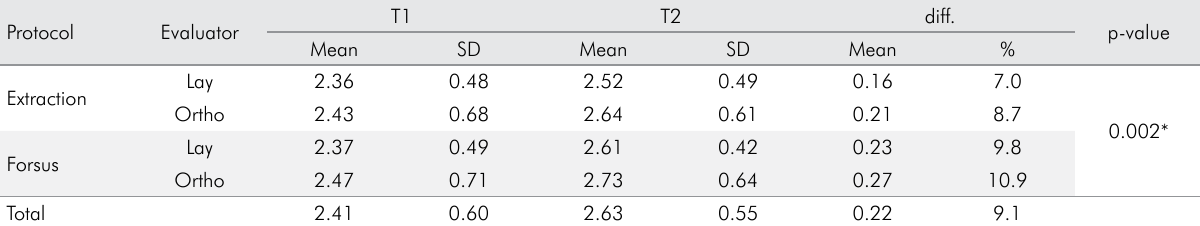
*statistically significant difference (p < 0.05).